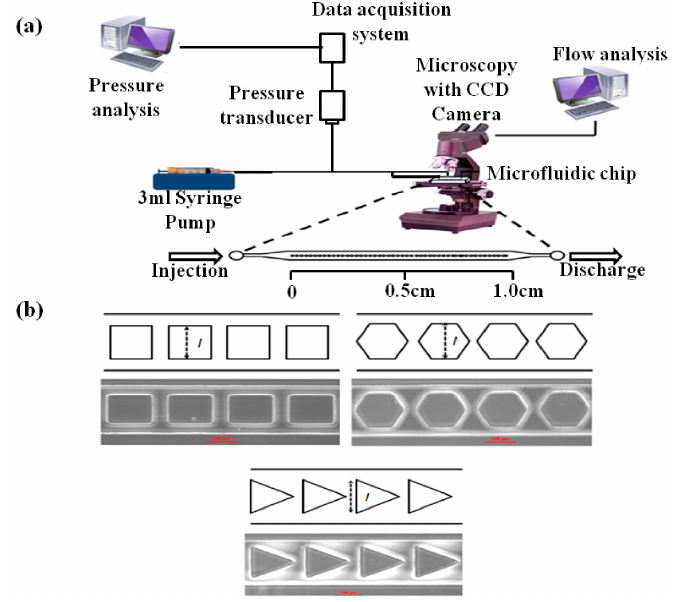
Figure 6. ( a ) Schematic diagram of the experimental apparatus; and ( b ) close-up image of the obstacles.